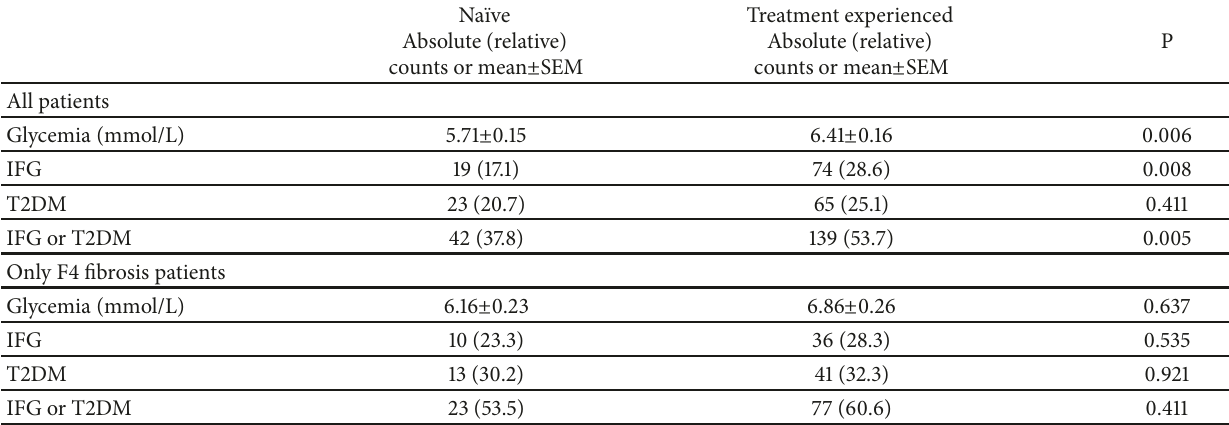
Table 4: Baseline levels of fasting glycemia and impaired fasting glucose or type 2 diabetes mellitus prevalence according to treatment experience.